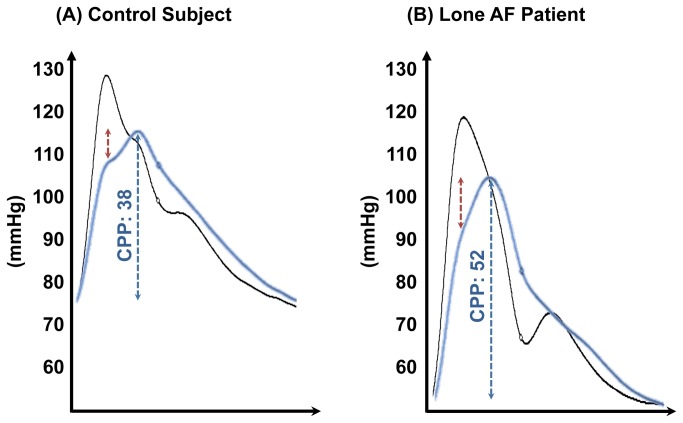
Examples of Peripheral and Central Pulse Waveforms.(A) Waveforms from a control subject showing peripheral pressures (black) of 128/76 with a pulse pressure of 52 mmHg and central pressures of 115/77 (blue) with a pulse pressure of 38 mmHg. Central augmentation pressure (red, dotted) is 7 mmHg. (B) Waveforms from a patient with lone AF showing peripheral pressures (black) of 120/54 with a pulse pressure of 66 mmHg and central pressures of 106/54 (blue) with a pulse pressure of 52 mmHg. Central augmentation pressure (red, dotted) is 12 mmHg.